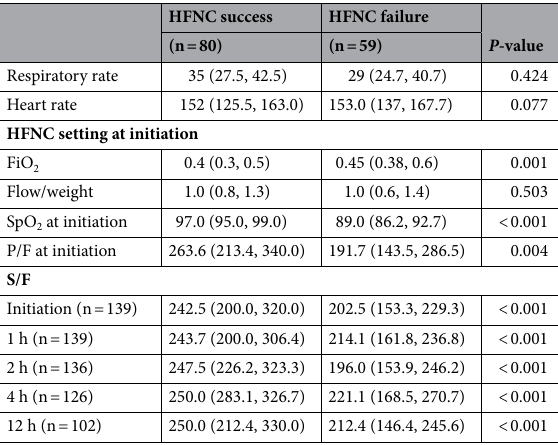
Table 2. Respiratory variables and serial S/F monitoring between HFNC success and failure groups during HFNC. Data are expressed as n (%) or medians (interquartile ranges). n, numbers; HFNC, high flow nasal cannula; FiO 2 , fraction of inspired oxygen; SpO 2 , pulse oximetry oxygen saturation; P/F, PaO 2 /FiO 2 ; S/F, SpO 2 / FiO 2 .